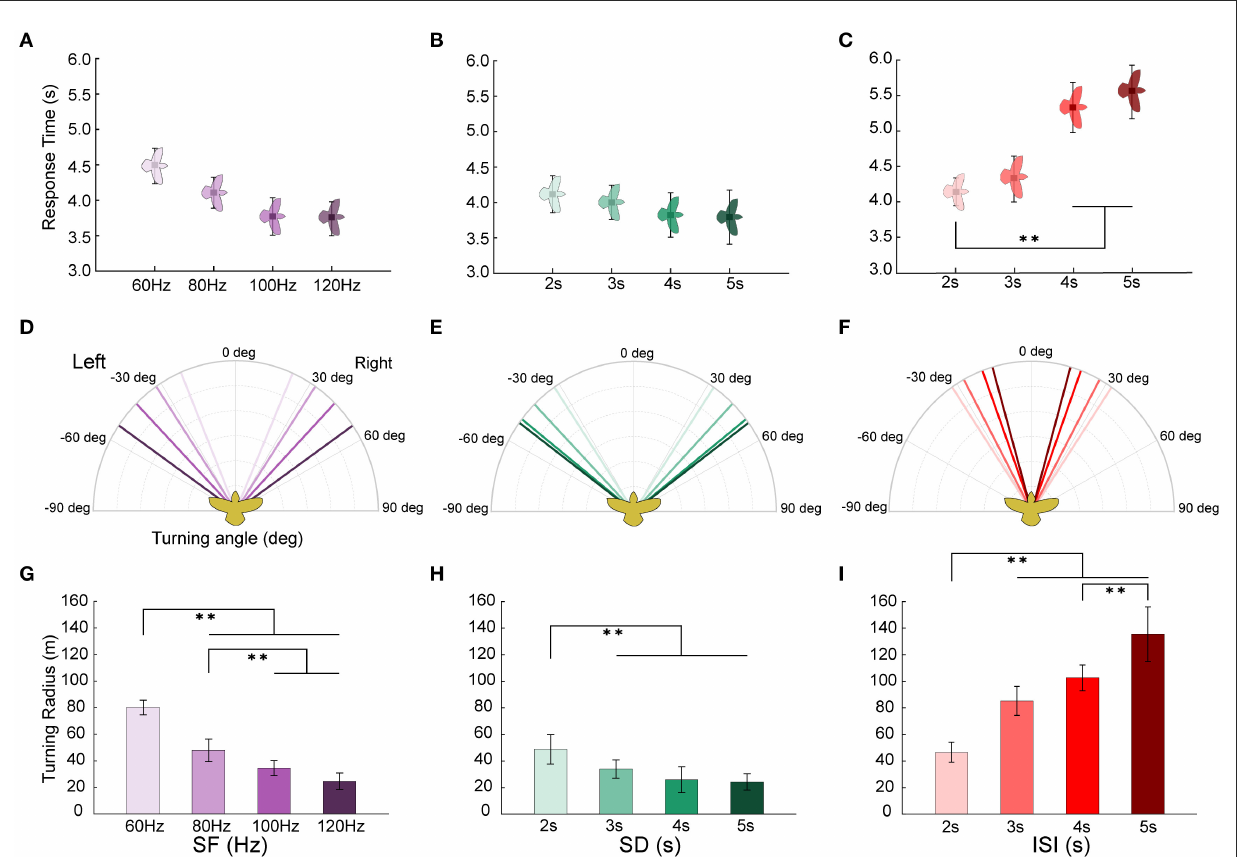
FIGURE6 Turning flight states of robo-pigeons after being stimulated. (A, D, G) denote the response time, turning angle and turning radius under the stimulus parameters of SF, respectively. (B, E, H) denote the response time, turning angle and turning radius under the stimulus parameters of SD, respectively. (C, F, I) denote the response time, turning angle and turning radius under the stimulus parameters of ISI, respectively. SF, the stimulus frequency; SD, the stimulus duration; ISI, the inter-stimulus interval. Each asterisk indicate significant differences in response time and turning radius, respectively ( ∗ p < 0.05, ∗∗ p <